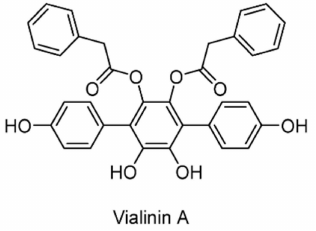
Figure 11. Structure of vialinin A.